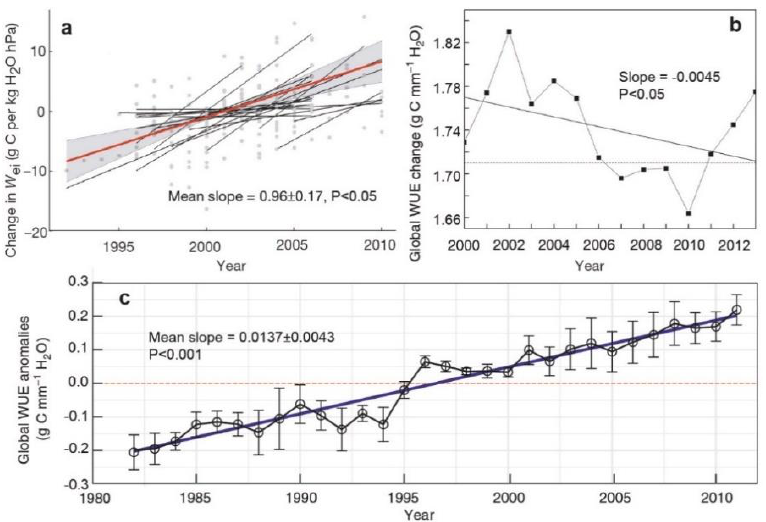
Figure 1. Trends of global water use efficiency (WUE). ( a ) The annual change in WUE ( 𝑊 𝑒𝑖 = WUE ∗ VPD , gC kg − 1 H 2 O hPa. VPD is atmospheric vapor pressure deficit), calculated using daytime fluxes from summer months at 21 flux towers of temperate and boreal forest ecosystems (discussed in Section 2.2.1). The red line indicates mean trend over all sites and grey dots and black lines represent the trends of each site. Adapted with permission from ref. [7]. Copyright 2013 Nature Publishing Group, a division of Macmillan Publishers Limited (https://www.nature.com/. Accessed on 15 April 2021). ( b ) Change in global annual mean WUE, calculated using satellite remote sensing data (dis- cussed in Section 2.2.3). The dashed line represents the mean value of WUE. Reprinted with permis- sion from ref. [9]. Copyright 2014 The authors . ( c ) Global WUE anomalies, calculated using output of an analytical ecosystem WUE model (discussed in Section 2.3). The blue line represents the linear trend of WUE and the error bars are standard deviation (Source: Cheng et al., 2017 [8]). Adapted with permission from ref. [8]. Copyright 2017 The authors.